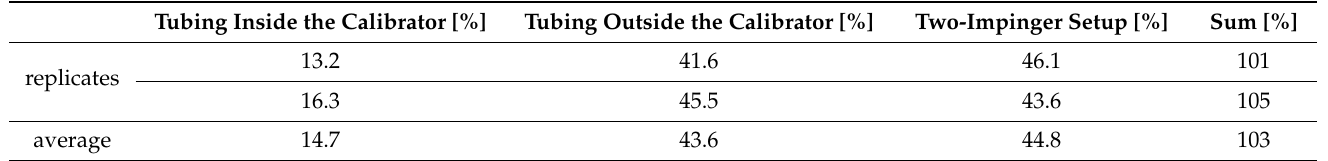
Table 2. The adsorption of the tubing inside and outside the calibration unit. A 70.7 ng m − 3 HgCl 2 gas concentration and a 125 ◦ C calibrator evaporation chamber temperature were